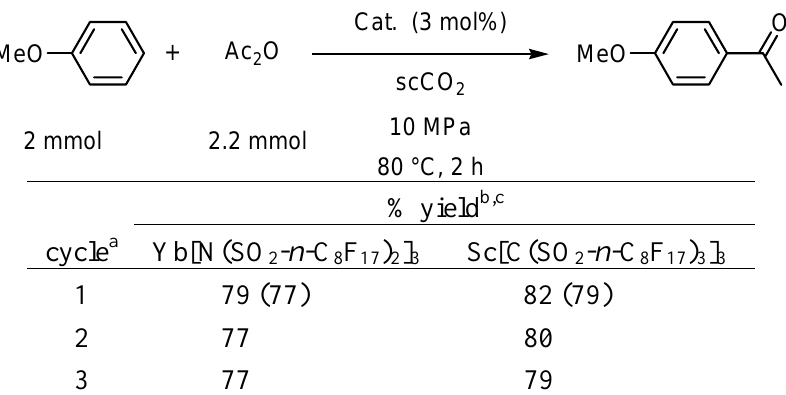
Table 8. Fluorous biphasic Friedel-Crafts acylation in scCO